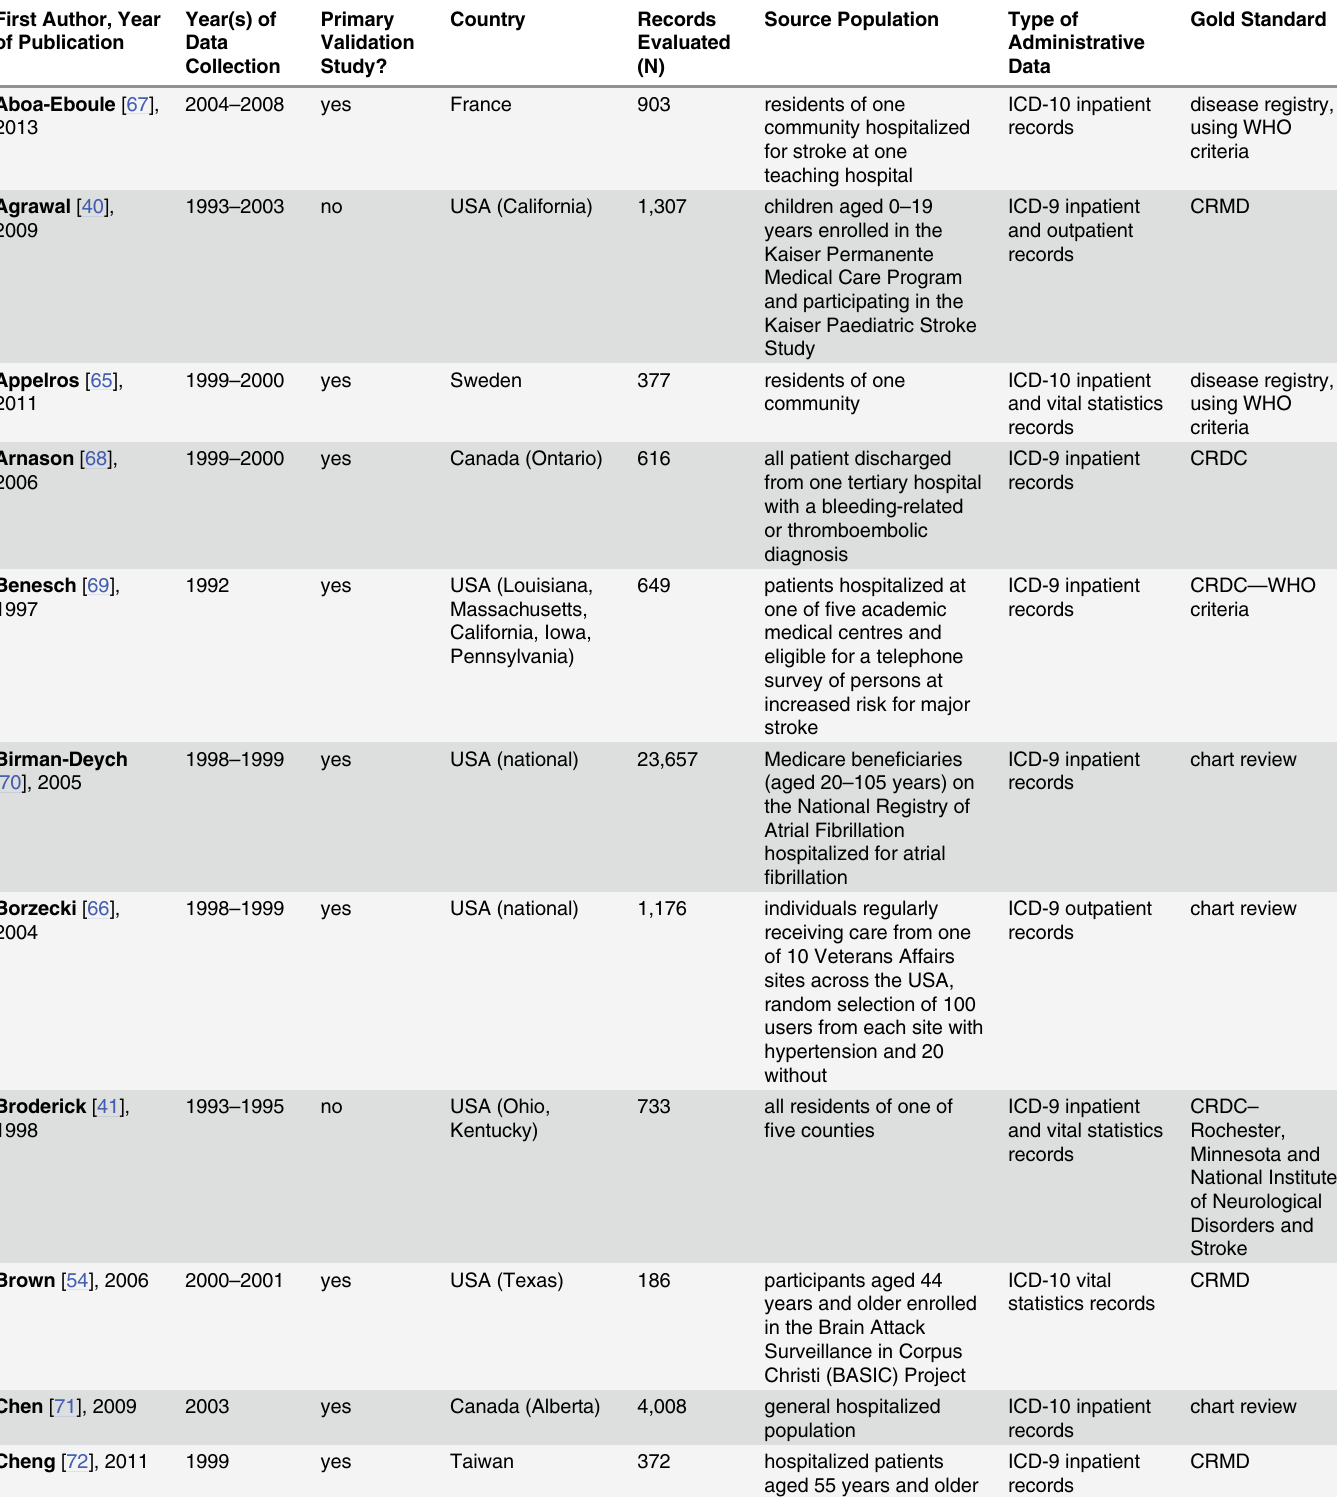
Table 1. Characteristics of Included